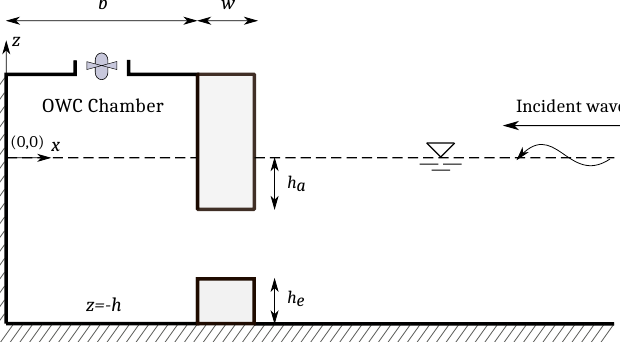
Figure 3. Definition sketch of an OWC device with a thick front